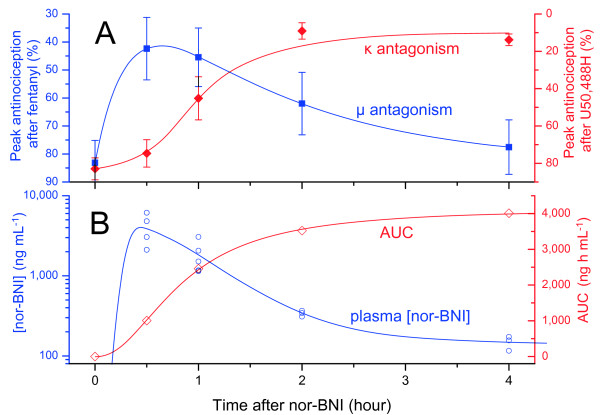
A, Reported timecourses of μ and κ antagonism over 4 hours after nor-BNI (mean ± SEM, 20 mg kg-1 s.c., mice[10]); B, nor-BNI plasma levels and mean area under curve (AUC) over the same period.